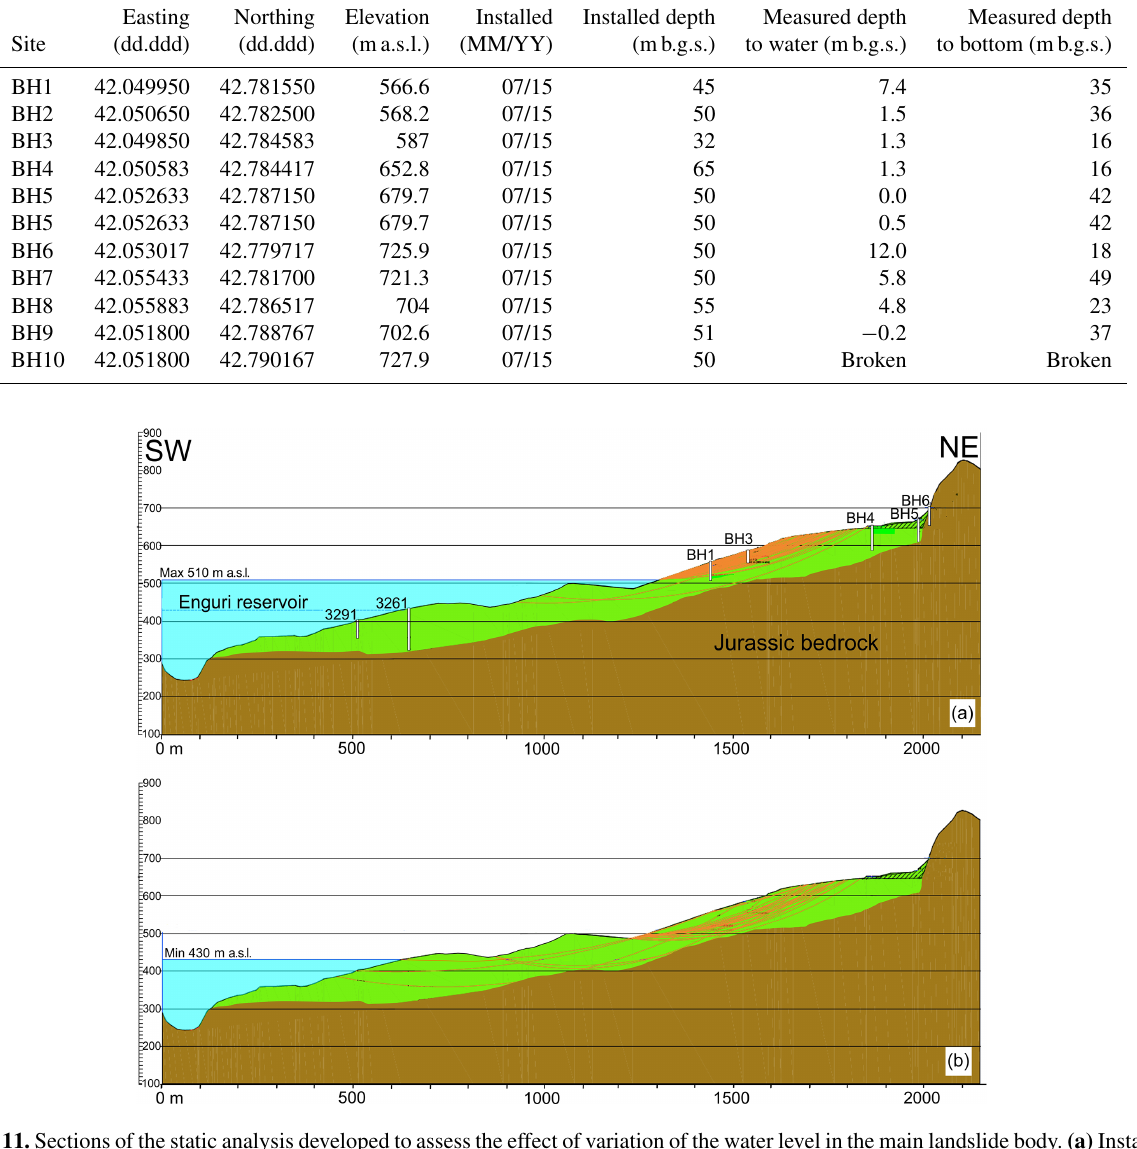
during the rainy season. The model indicates that upper parts of the slope are unstable along curvilinear slip surfaces (or- ange lines) that correspond to the factor of safety (FS) <